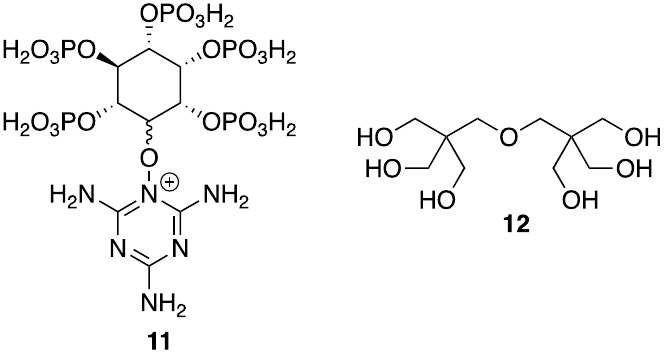
Figure 7. Chemical structures of 8 , 9 , and 10.